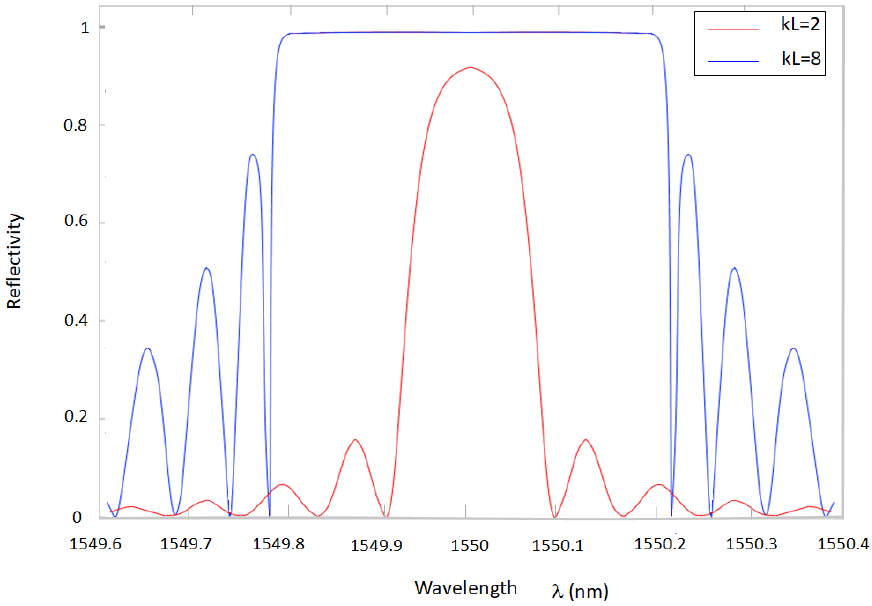
Figure 5. Reflectivity of an FBG with λ B = 1550 nm, kL = 2 (red curve), and kL = 8 (blue curve).